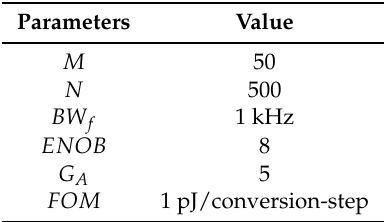
Table 2. AIC system simulation parameters for power consumption in